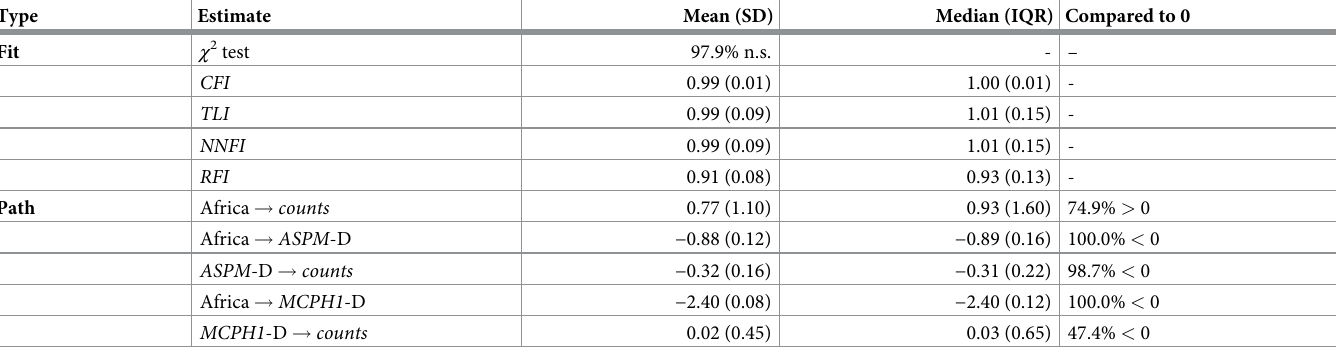
Table 14. Summaries of the path analysis for 1,000 restricted samples for tone counts . Similar conventions as for Table